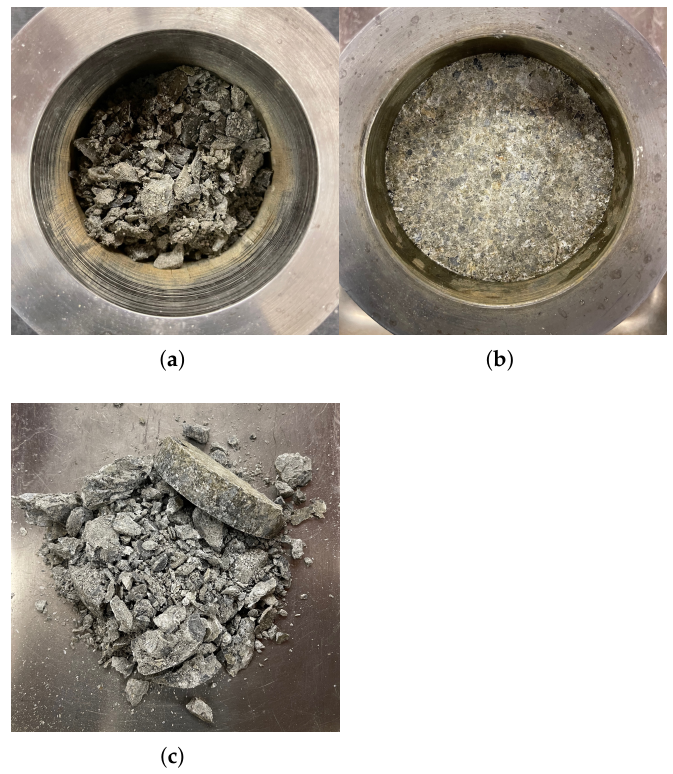
Figure 4. Material compression on the PPT: ( a ) Uncompressed material in die; ( b ) Material after compression; ( c ) Unloaded compressed